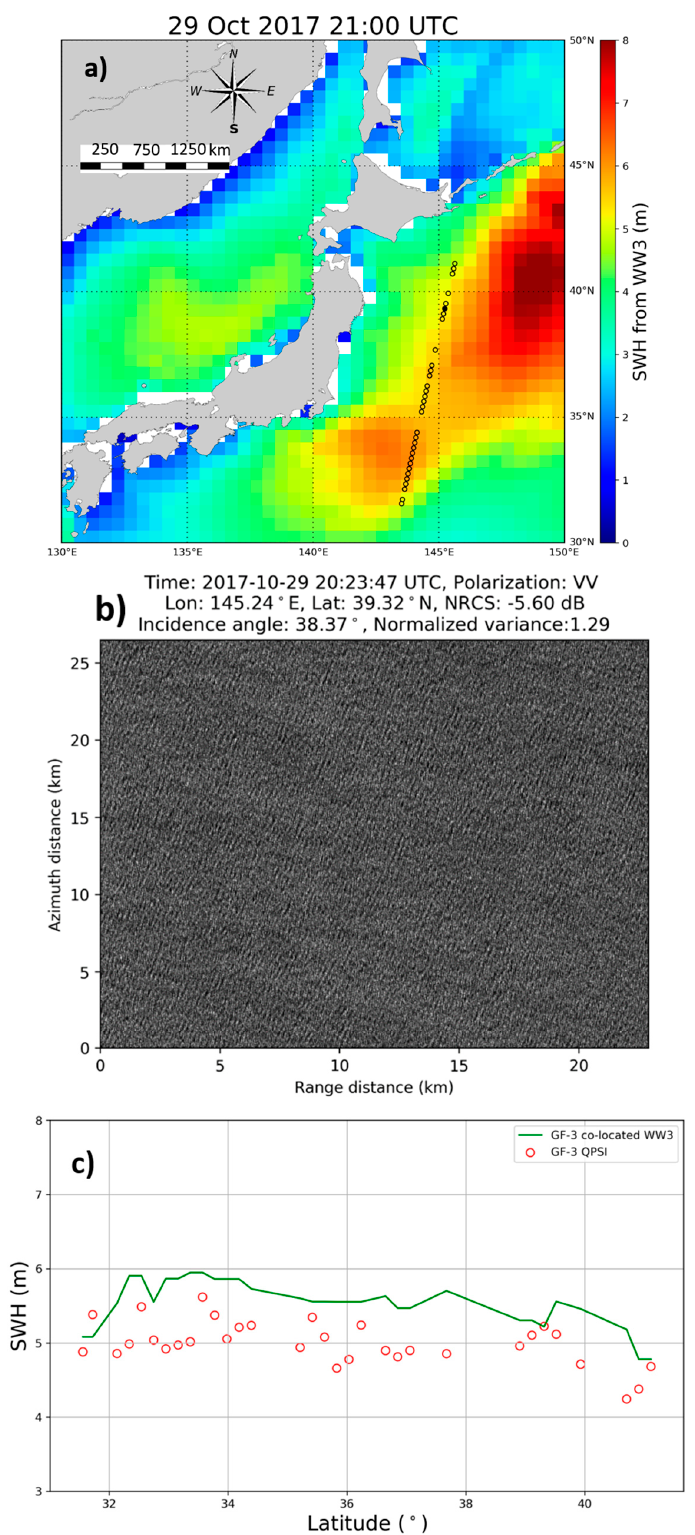
Figure 12. GF-3 in QPSI mode and WW3 SWH comparison for the case on 29 October 2017. ( a ) Colors represent the WW3 SWH hindcast at 21:00 UTC, with circles representing the acquisition of GF-3 in QPSI mode; ( b ) An example of GF-3 QPSI SAR image acquired at 22:23; ( c ) The red dots and green line represent the SWH from QPCWAVE_GF3 retrievals and WW3 along the pass of GF-3, respectively.